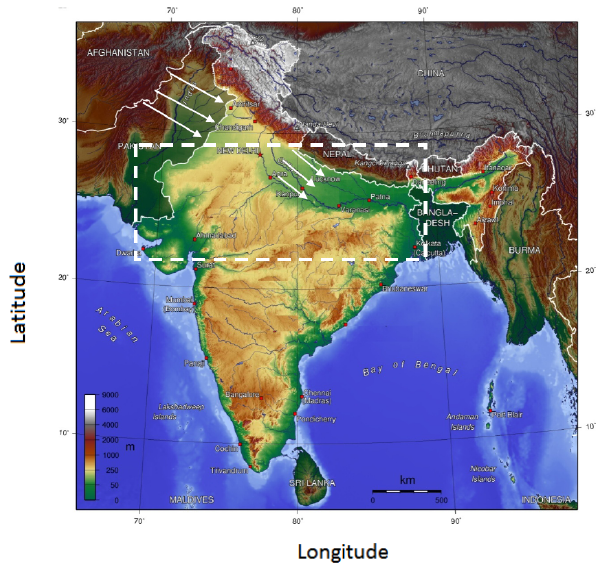
Fig. 1 Map of India with grid chosen for the study. Major industrial and urban locations are also shown.